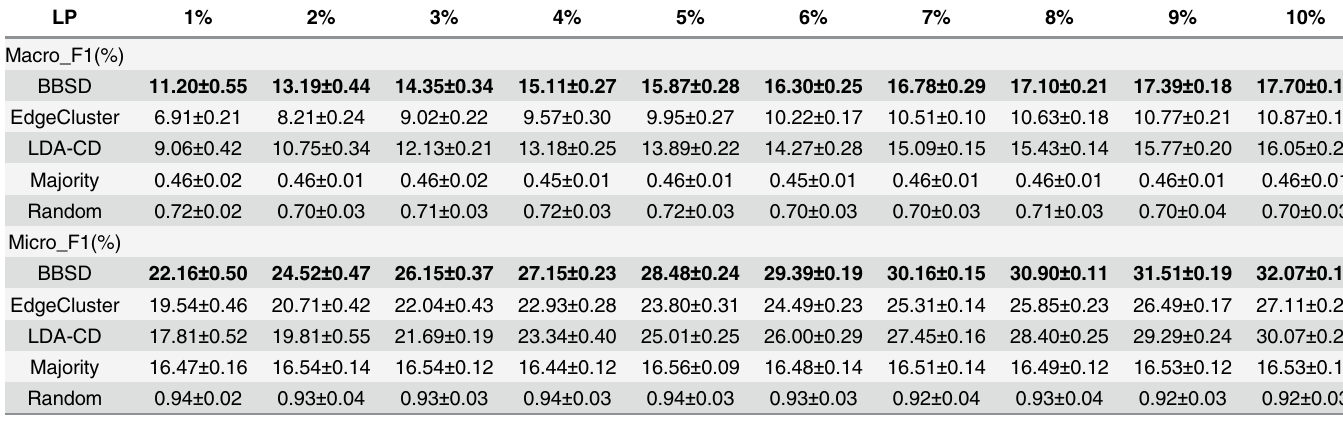
Table 2. Classification performance on Flickr